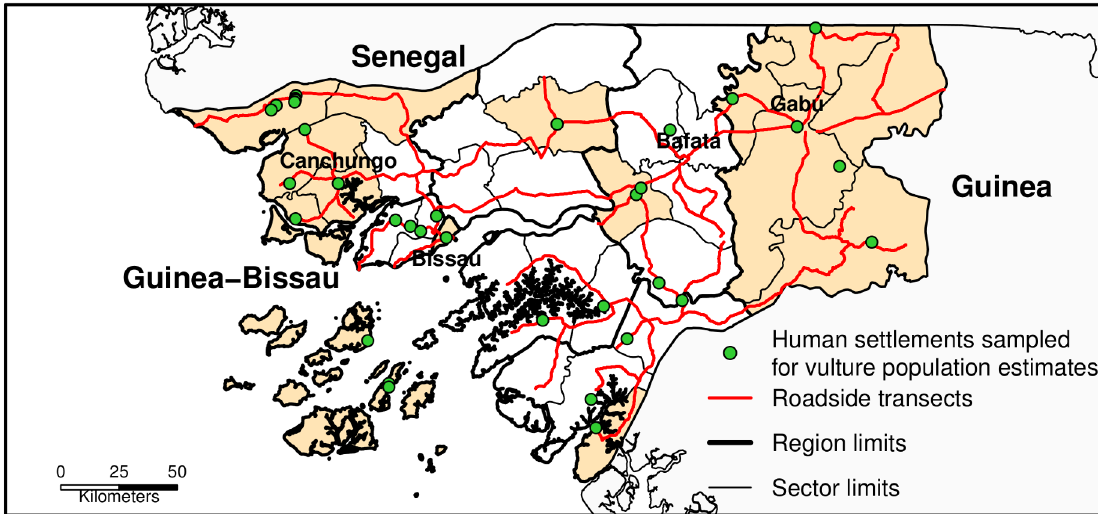
Fig 1. Map of the study area. Areas without red lines correspond to Sectors (an administrative division within Guinea-Bissau) that were not sampled for the study of vulture distribution and abundance (i.e. no road surveys were conducted). Orange areas are Sectors where interviews were carried out for the social surveying component of our study. The four major cities of the country are represented by their names in black writing.